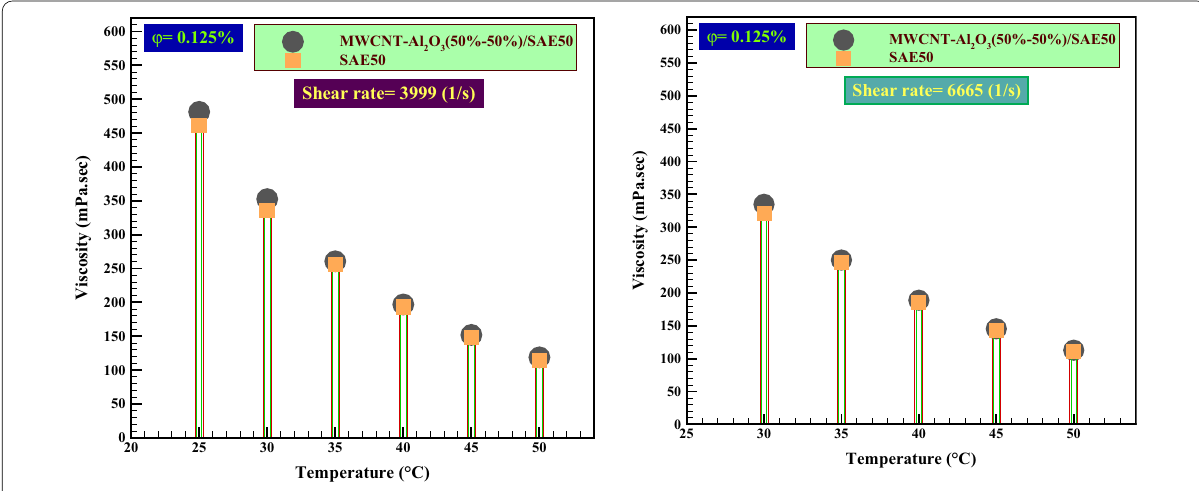
Fig. 10 Comparison of the effect of temperature on µ nf at ϕ